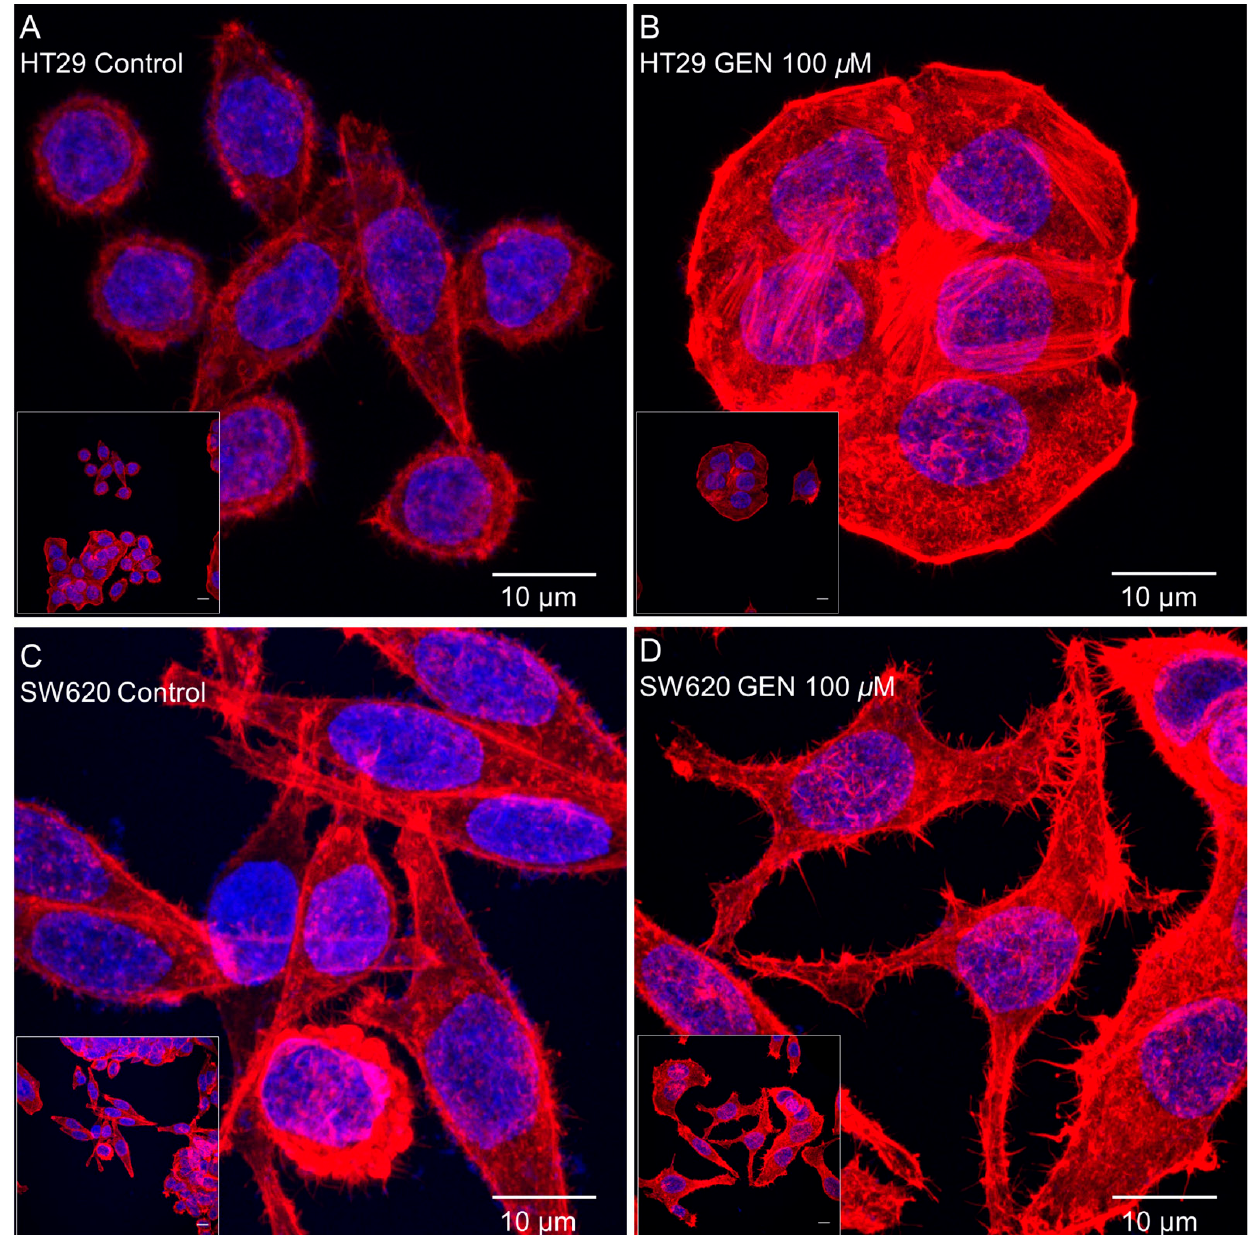
Figure 6. Effects of genistein on actin cytoskeleton in ( A , B ) HT29 cells and ( C,D ) SW620 cells, determined by Phalloidin staining. The measurements were made with 0.1% DMSO (control cells, ( A,C )) or genistein 100 µ M ( B,D ) treatment for 48 h. The fluorescence was monitored with a Leica TCS-SPE Confocal Microscope, using 63 × immersion oil (147 N.A.) objective lens. Scale bar 10 µ m. White square in the bottom left corner shows the whole field without zoom and the image in the center shows a zoom from the white square image. Nucleus and actin cytoskeleton are represented in the picture in blue and red,